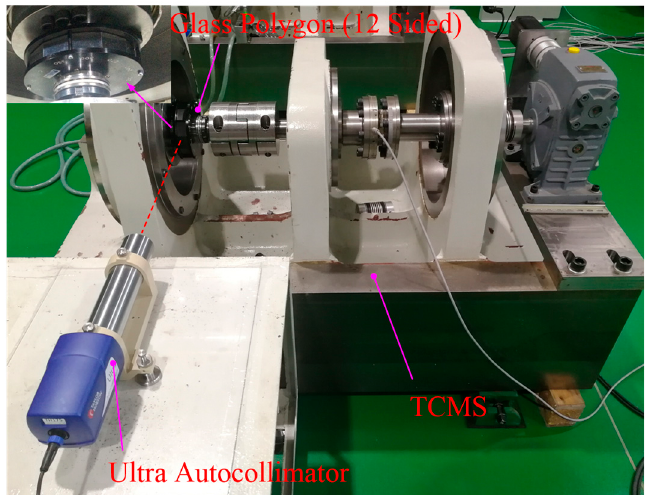
Figure 6. Verification experiment using an ultra-autocollimator.